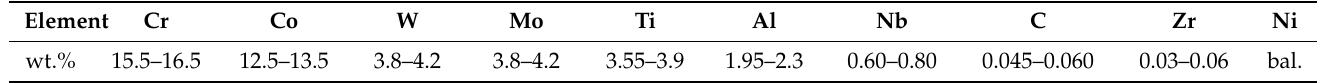
Table 1. Chemical composition of FGH96 powder